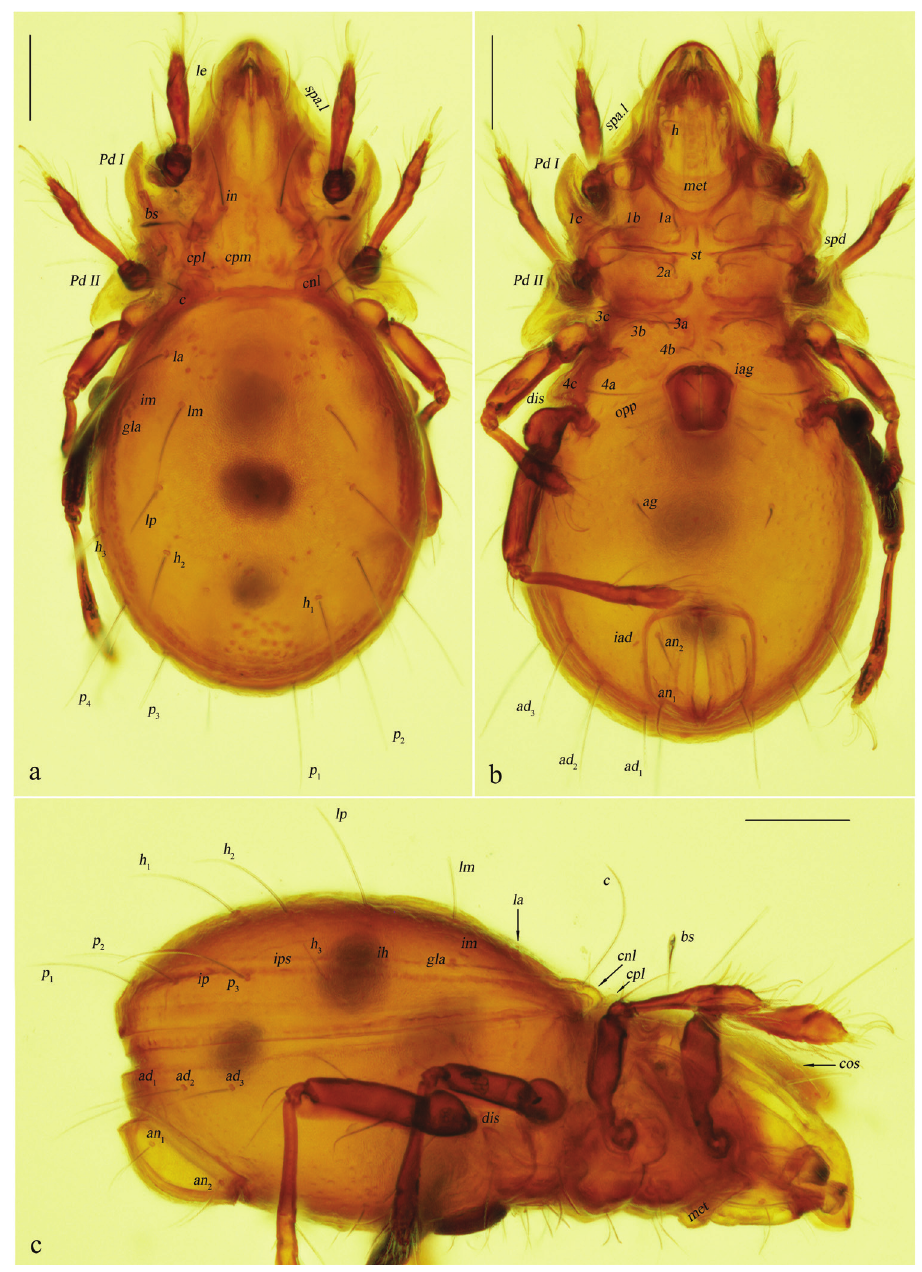
Figure 12. Eurostocepheus ( Eurostocepheus ) mahunkai Mondal & Kundu, 1999, adult, microscope images: a dorsal view, ventral view c lateral view. Abbreviations and notations explained in text. Scale bars: 100